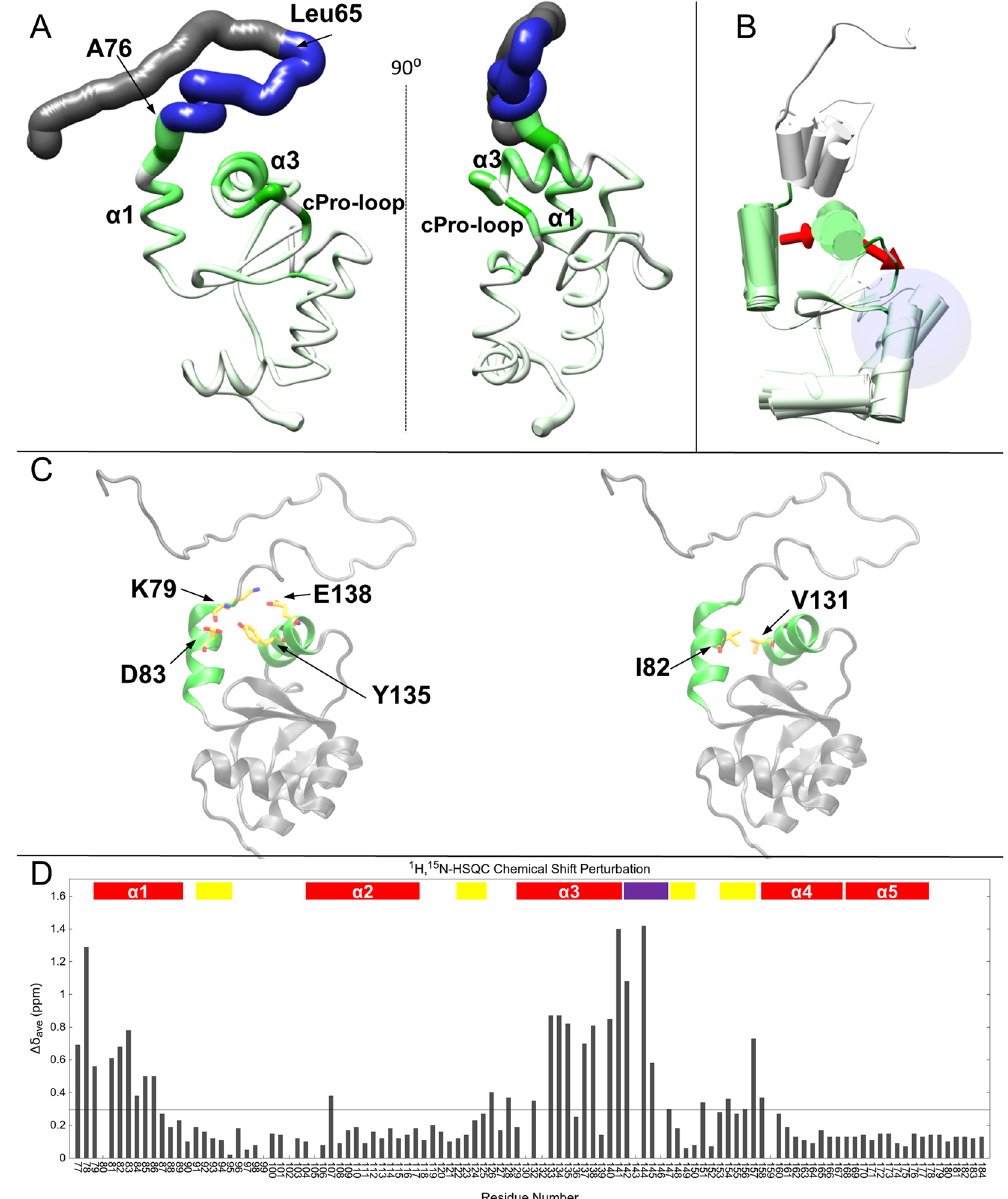
Figure 5. Proposed mechanism for the interaction of the NTE (IDR) with the GSH-binding site. In panel (A), the position of the deletion segment corresponding to Δ 64, Δ 76 are indicated on the FL 1CGrx1 (AA 42-184) structure. Segment 42–64 is coloured in grey, segment 65–76 is coloured in blue while the globular domain 77– 184 is coloured in a green-to-white palette according to the chemical shift perturbations measured comparing the 1 H- 15 N HSQC of the full-length and truncated Δ 76 forms. The green-to-white palette indicates strong-to- none CSPs (see panel D for CSP values). Panel (B) represents a model describing how the fluctuations of the helix α 1, due the attached NTE, can be transferred to the GSH-binding site through the interposed helix α 3 and can therefore influence its conformation and dynamics. The ribbon is coloured according to the chemical shift perturbations above mentioned. The residues involved in the electrostatic and hydrophobic interactions connecting α 1 and α 3 (in green) are represented as stick in the 1CGrx1 structures shown in panel (C). In panel (D), the CSPs are plotted in a histogram reporting the averaged perturbation in ppm ( ∆ δ AVE ) for each residue. The secondary structure elements are reported within the plot while the black line is plotted at a value corresponding to the average CSP